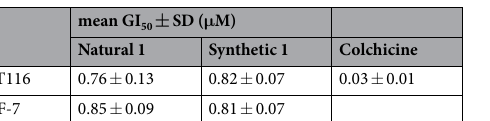
Table 1. GI 50 values of natural product and synthetic jerantinine A ( 1 ) and colchicine against human-derived colorectal (HCT116) and mammary (MCF-7) carcinoma cell lines. Data calculated from n ≥ 3 trials; n = 8 per concentration point per